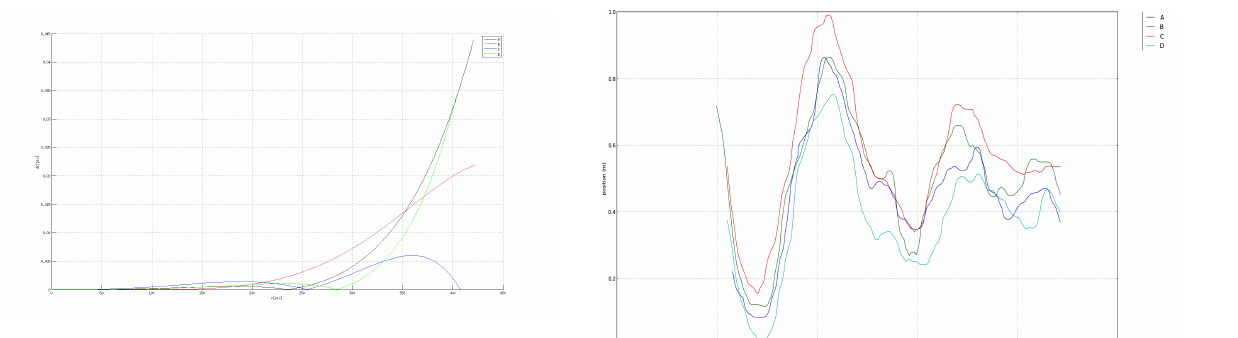
Figure 7: Radial symmetric distortion curves for all RGB sensors